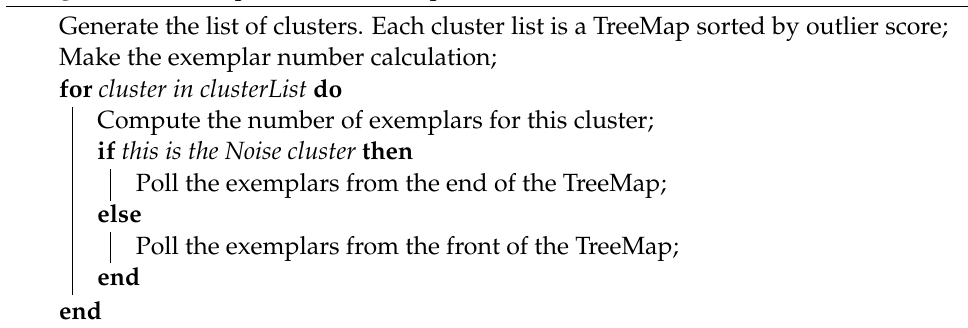
Algorithm 2: Compute cluster